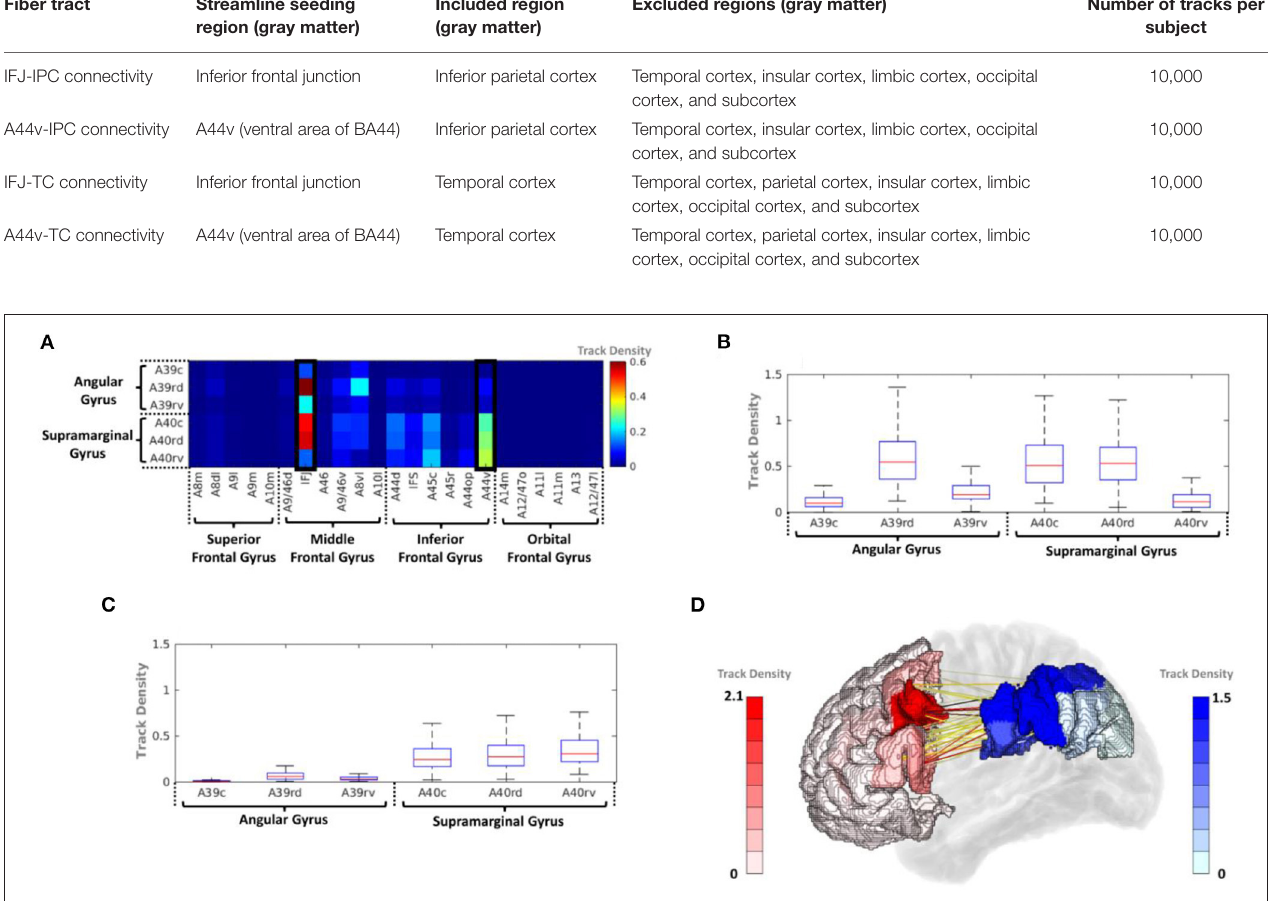
FIGURE 4 | (A) Average track-density matrix of the acquired fiber tracts from the PFC–IPC. (B) Box-and-whisker plot showing the IFJ–IPC connectivity specifically for the regions indicated in (A) . (C) Box-and-whisker plot showing the A44v connectivity specifically for the regions indicated in (A) . (D) Three-dimensional visualization of track density in PFC–IPC connectivity. A8m, medial area 8; A8dl, dorsolateral area 8; A8vl, ventrolateral area 8; A9l, lateral area 9; A9m, medial area 9; A10m, medial area 10; A9/46d, dorsal area 9/46; A10l, lateral area 10; A11l, lateral area 11; A11m, medial area 11; A12/47l, lateral area 12/47; A12/47o, opercular area 12/47; A13, area 13; A14m, medial area 14; A39c, caudal area 39; A39rd, rostrodorsal area 39; A39rv, rostroventral area 39; A40c, caudal area 40; A40rd, rostrodorsal area 40; A40rv, rostroventral area 40; A44d, dorsal area 44; A44op, opercular area 44; A44v, ventral area 44; A45c, caudal area 45; A45r, rostral area 45; A46, area 46; IFJ, inferior frontal junction; IFS, inferior frontal